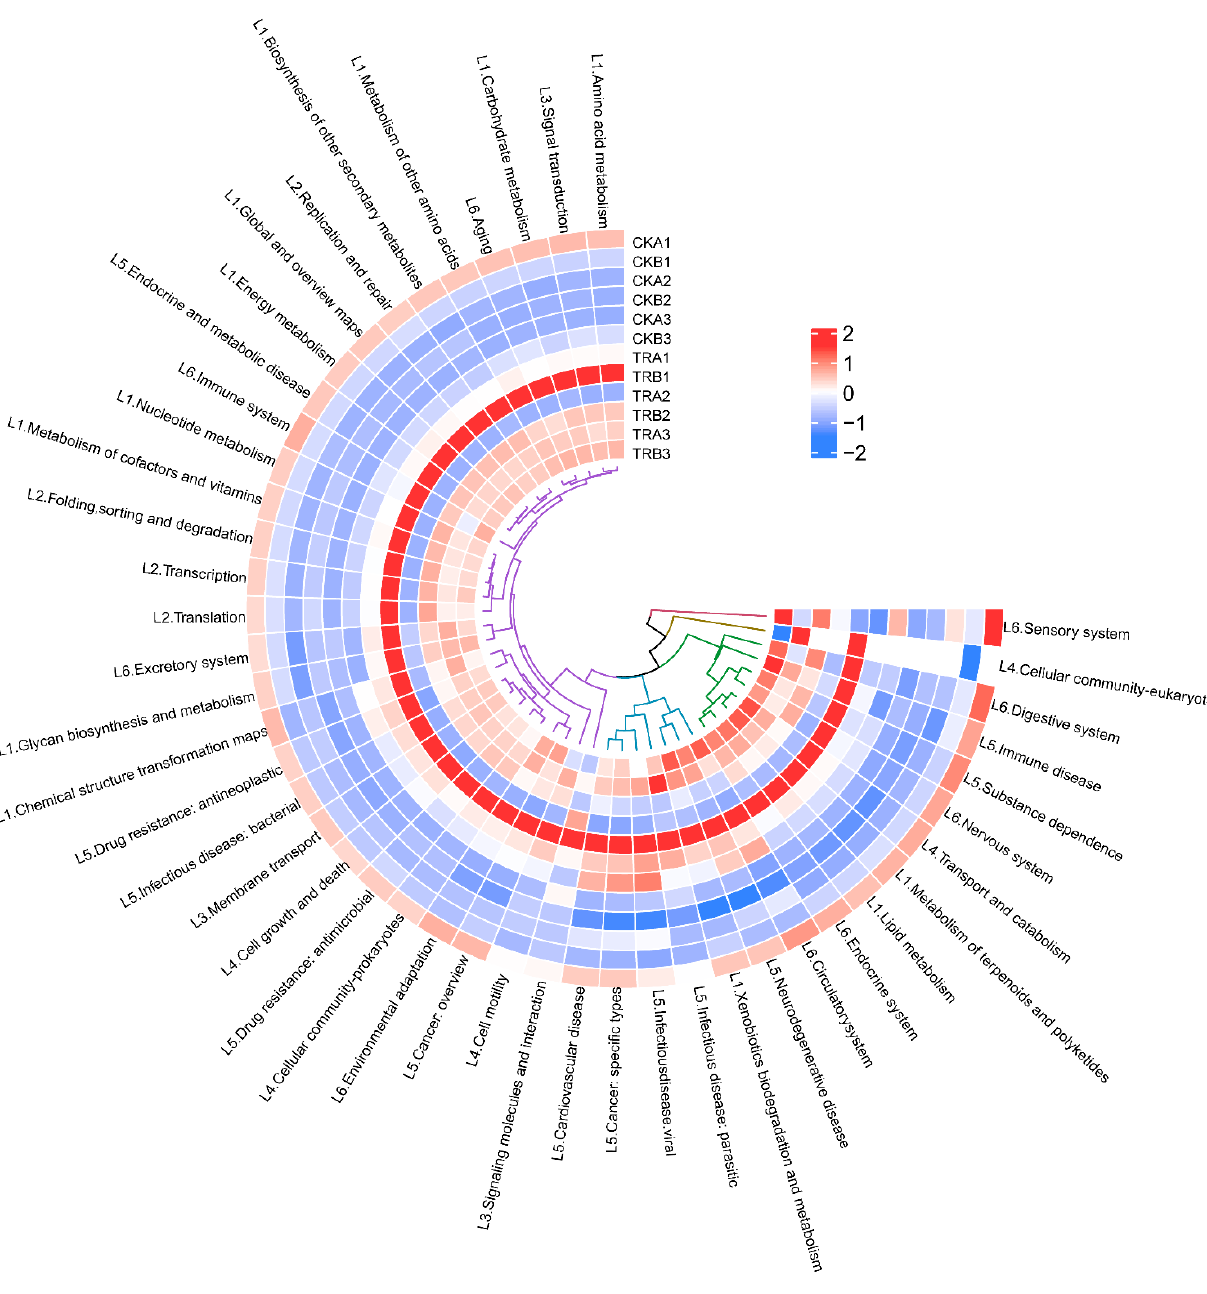
Figure 6. Heat map of PICRUSt2 based functional predicted for bacterial of different samples (hierarchy level 2). L1–L6 stands for hierarchy level 1: L1 stands for metabolism, L2 stands for genetic information processing, L3 stands for environmental information processing, L4 stands for cellular processes, L5 stands for human diseases, L6 stands for organismal systems. CKA1, CKA2, and CKA3 represent three repetitions of CKA, and so